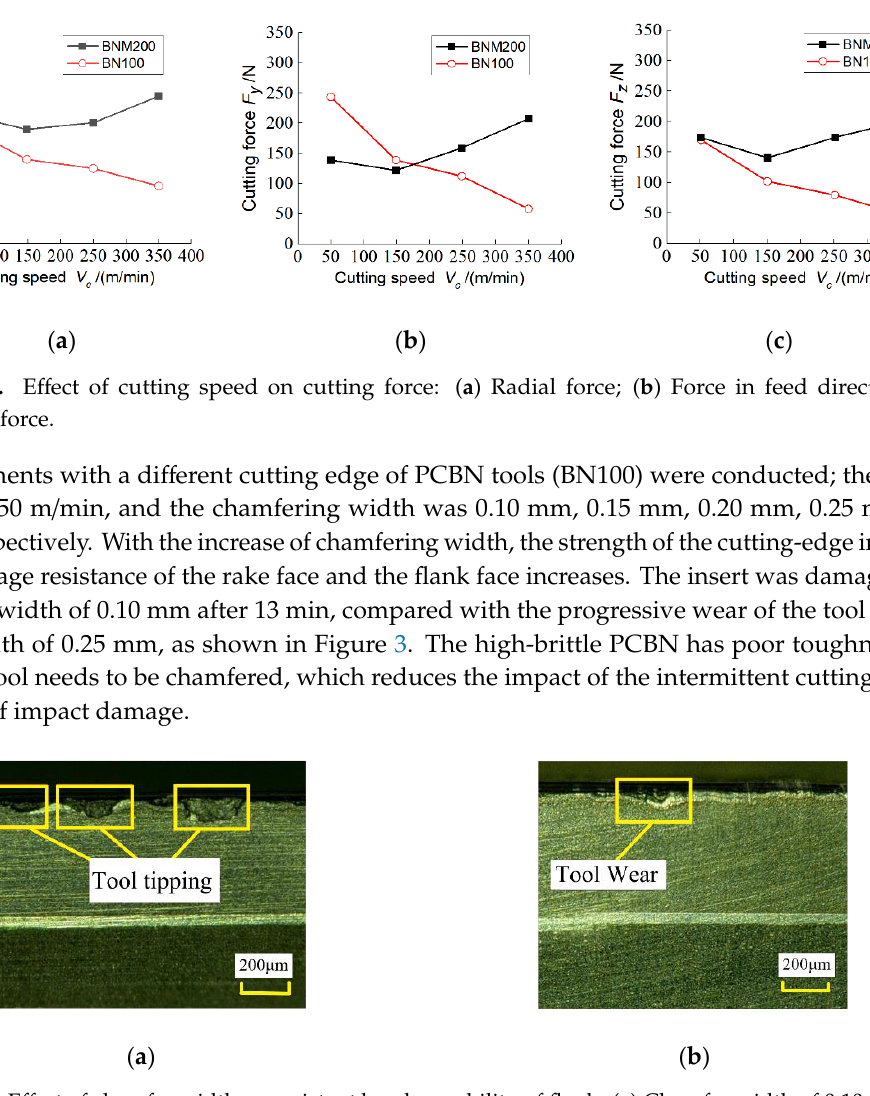
Figure 3. Effect of chamfer width on resistant breakage ability of flank: ( a ) Chamfer width of 0.10 mm; ( b ) Chamfer width of 0.25 mm.